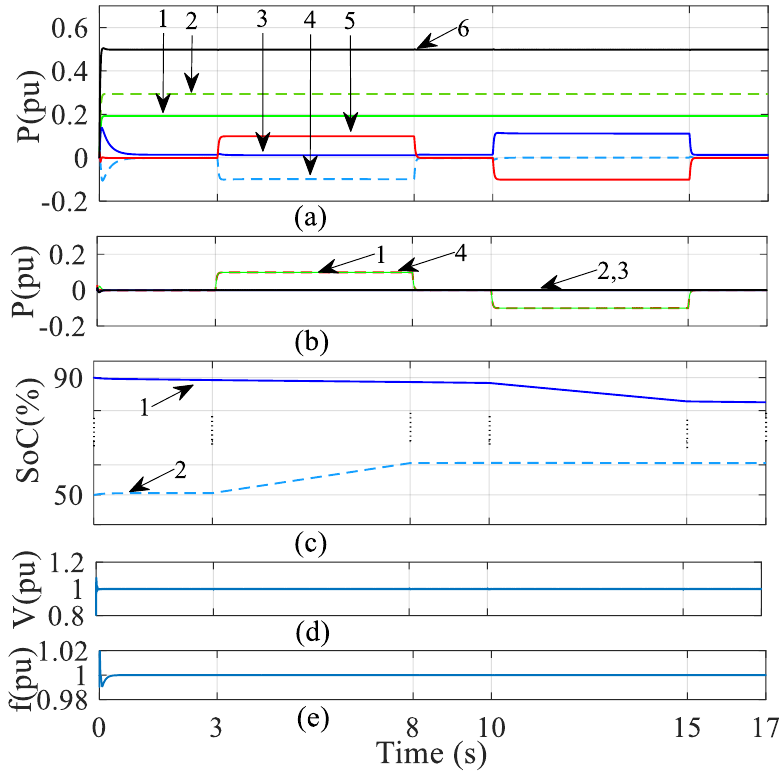
Figure 12. Central power coordination. ( a ) Power (pu), 1— P pv 1 ; 2— P pv 2 ; 3— P b 1 ; 4— P b 2 ; 5— P g ; 6— P L . ( b ) Power from MGSCs (pu), 1— P g 1 ; 2— P g 2 ; 3— P g 3 ; 4— P g . ( c ) SoC (%), 1— SoC 1 ; 2— SoC 2 . ( d ) V L (pu). ( e ) Load frequency (pu).